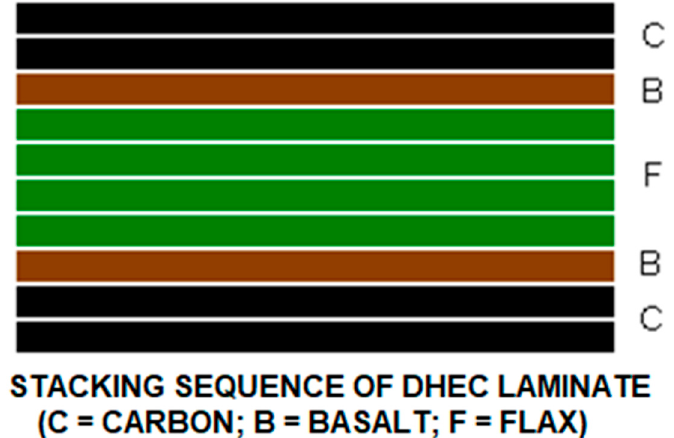
Figure 3. The DHEC laminates (original picture from the author of the chapter) [33].